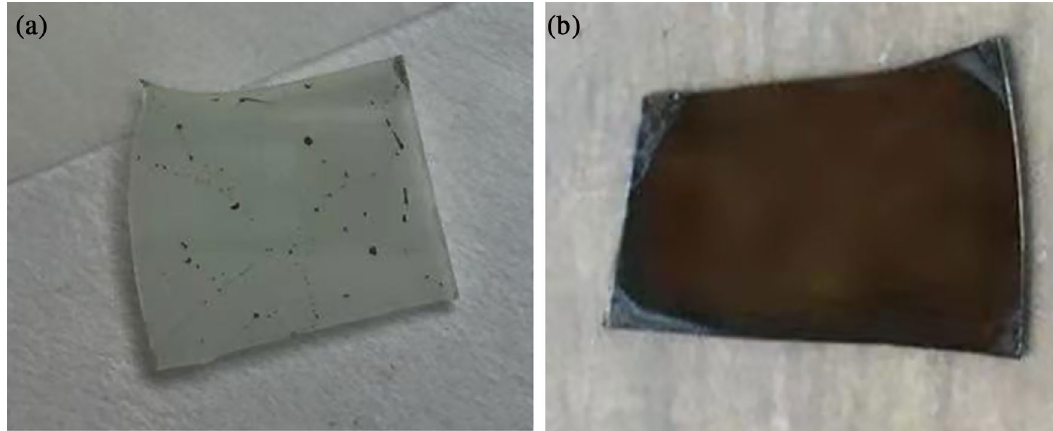
Figure 2. Top-view optical images of the perovskite films grown on the NP-GaN DBRs untreated ( a ) and treated ( b ) by